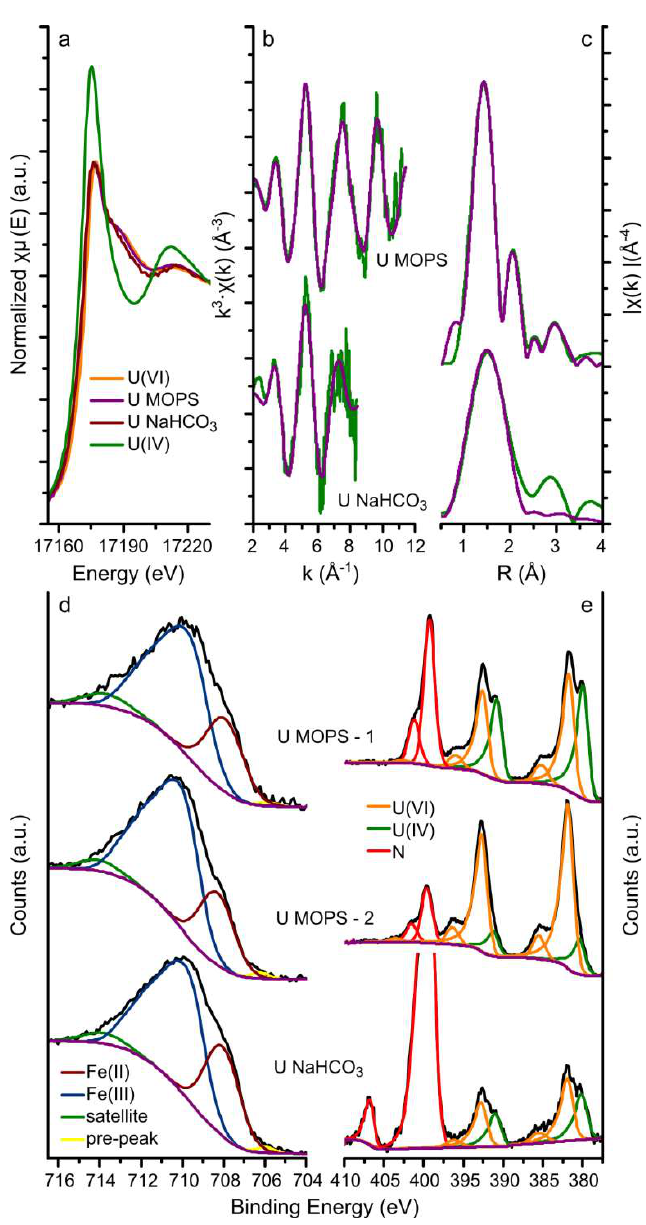
Figure 2. Uranium L III -edge GI-XAS and the XPS data. Uranium L III -edge GI-XAS results: ( a ) XANES with U(IV) and U(VI) in-house standards; and ( b , c ) the EXAFS (green lines) and corresponding fits (purple lines) to the U MOPS and U NaHCO 3 samples; XPS data for the iron 2p 3/2 transition ( d ) and the uranium 4f 7/2 and 5/2 transitions ( e ) (black lines) and the fits (coloured lines, blue and purple lines represent Fe(III) and Fe(II), respectively, and the orange and green lines represent U(VI) and U(IV), respectively) to the spectra of the U MOPS and U NaHCO 3 samples, in the iron 2p 3/2 plot ( d , e ), the fitted Fe(II) and Fe(III) peaks have been merged for clarity; the U MOPS sample was analysed for XPS on two locations, denoted by – 1 and – 2.